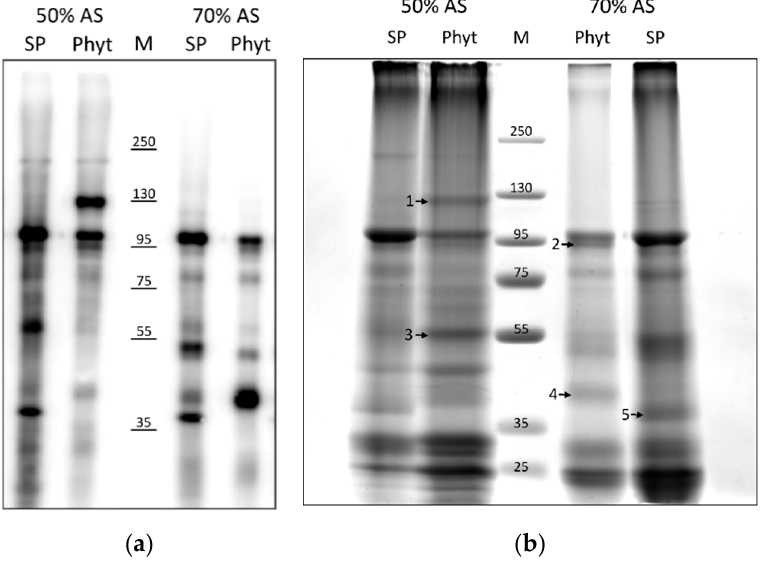
Figure 4. Visualizing the candidate protein interactors of Nt Phyt. Proteins biotinylated in Nt Phyt ‐ TurboID ‐ or SP ‐ TurboID ‐ producing leaves during the incubation of leaf samples with 200  M biotin for 5 h (Phyt and SP, respectively) were isolated from the respective intracellular fractions (obtained from equal 5 g amounts of leaf tissues) by extraction in the presence of 0.5% dodecyl maltoside. Upon ammonium sulphate (AS) fractionation, biotinylated proteins precipitated with 50% AS and 70% AS were separated by affinity chromatography on streptavidin magnetic beads and analysed by SDS gel electrophoresis. ( a ) On ‐ blot detection of biotinylated proteins using streptavidin ‐ HRP. One % of the affinity purified protein samples in 4  L aliquots were loaded. ( b ) The rest of the samples, after acetone precipitation, were dissolved in 45  L of SDS ‐ containing buffer and analysed by SDS gel electrophoresis. Coomassie blue staining of the 6 ‐ 16% gradient polyacrylamide gel. Arrows with numbers indicate the bands chosen for protein identification by mass spectrometry (MS) analysis. M, molecular weights of the protein